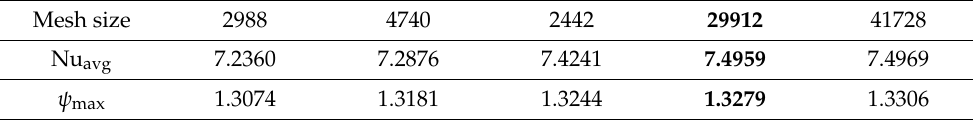
Table 2. Evaluation of the mean Nusselt number (Nu avg ) and ψ max for diverse grid resolution. Mesh